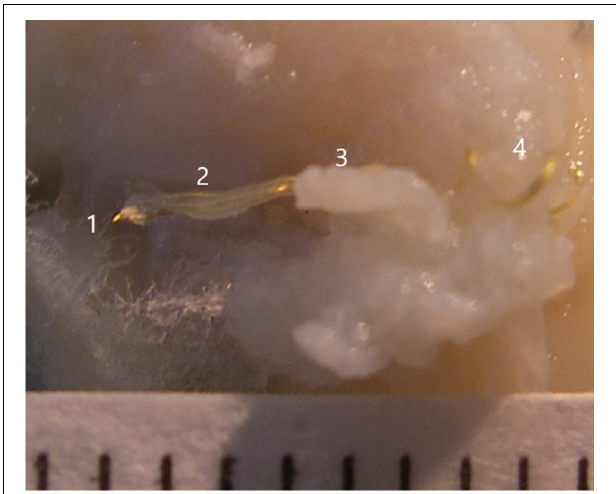
FIGURE 5 | Illustration of the waveforms of single units from both channels on day 748 after implantation.